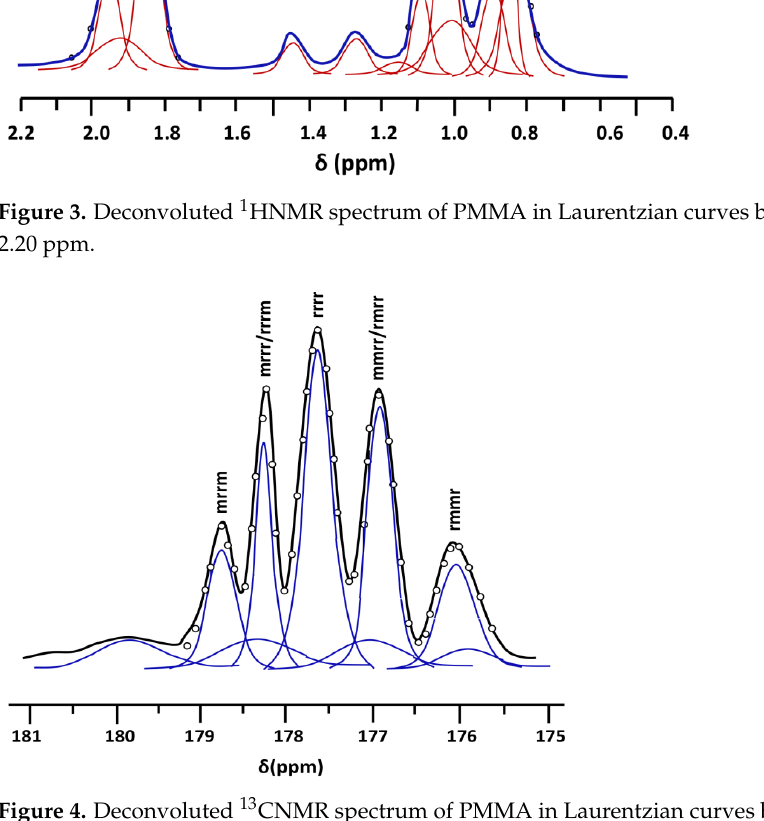
Figure 4. Deconvoluted 13 CNMR spectrum of PMMA in Laurentzian curves between 175 ppm and 181 ppm. Table 1. 1 H NMR assignments characterizing the triads and tetrads in PMMA using CDCl 3 as the solvent [27] .